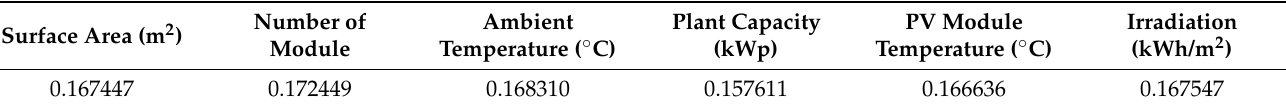
Table 6. Weight to Input or